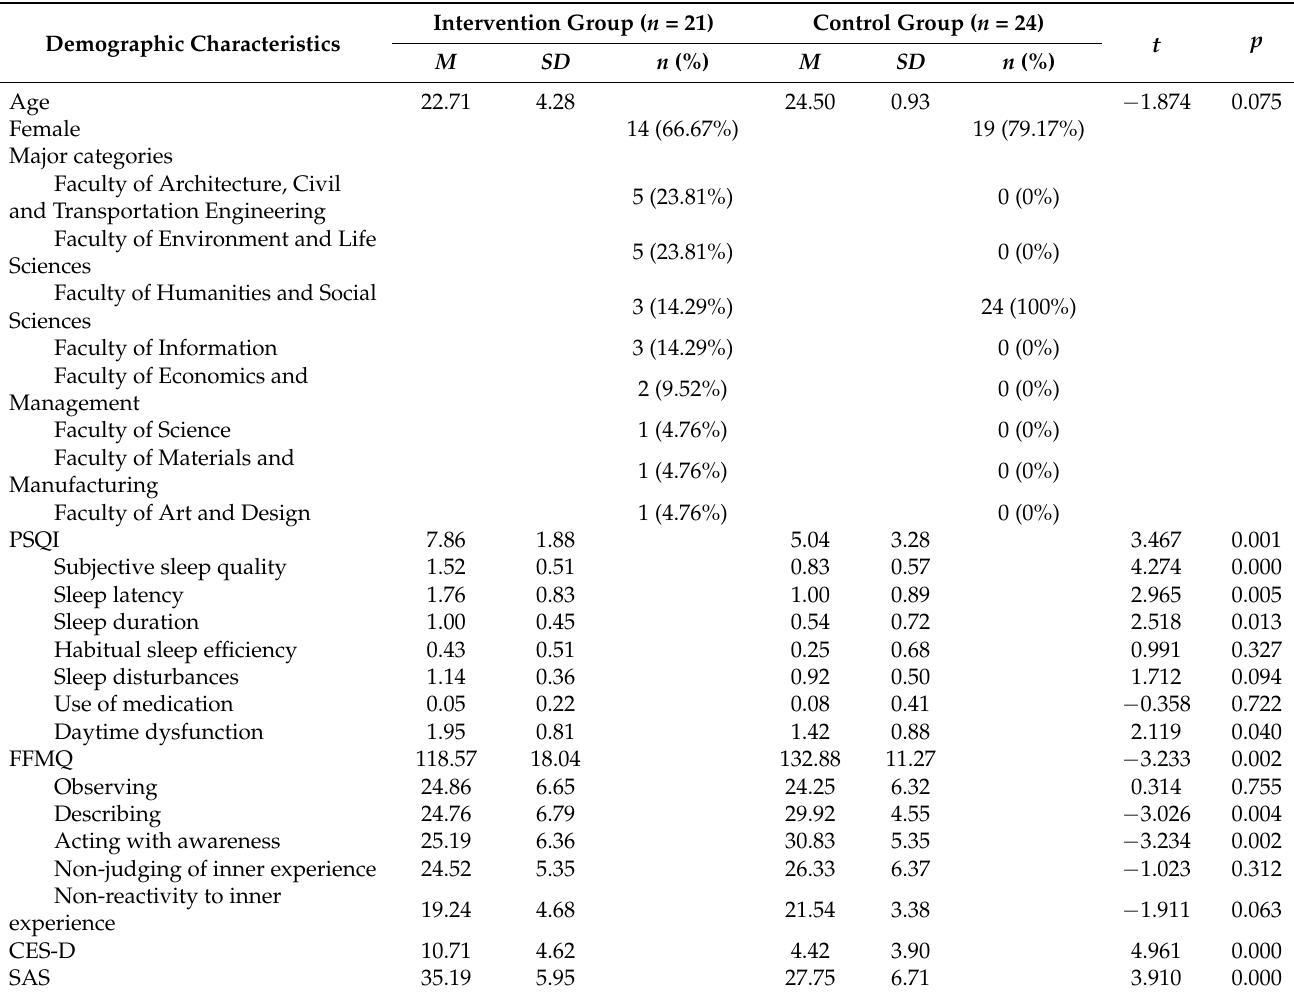
Table 1. Demographic characteristics of the two groups at